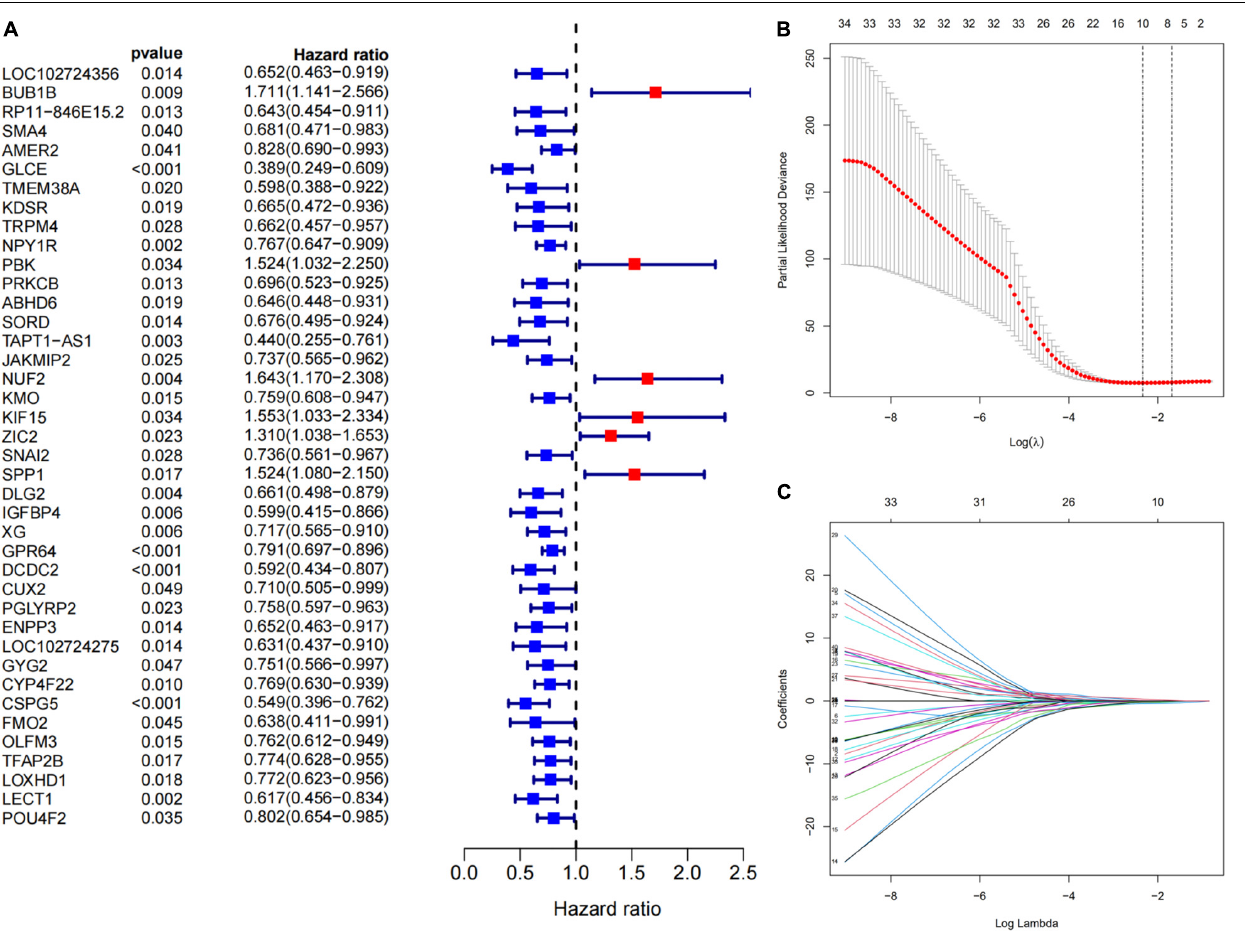
FIGURE 5 | Construction of immune-related genes prognostic signature. (A) The p -value and HR of selected genes in univariable Cox regression analysis ( p < 0.05). (B) The LASSO regression identified 10 genes associated with prognosis. The partial likelihood deviance plot presented the minimum number corresponds to the covariates used for LASSO Cox analysis. (C) A coefficient profile plot was generated against the log (lambda) sequence. Selection of the optimal parameter (lambda) in the LASSO model for GEO cohort.